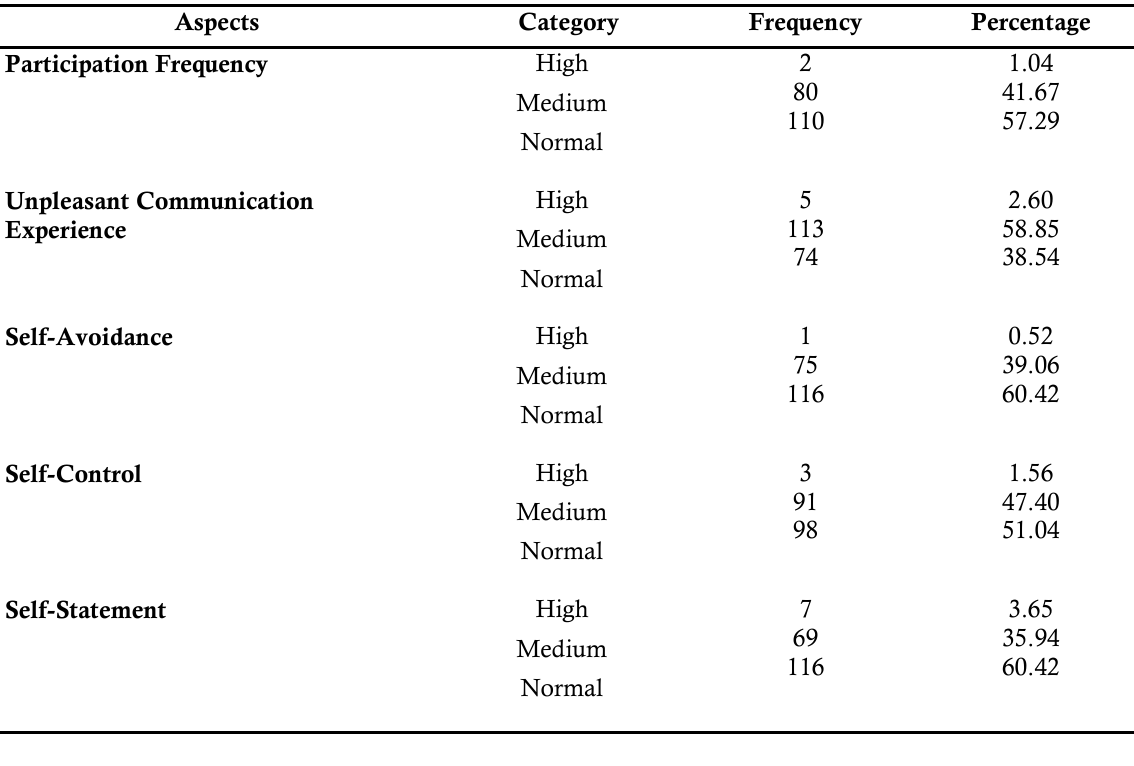
Table 1: Aspects of frequency of student anxiety